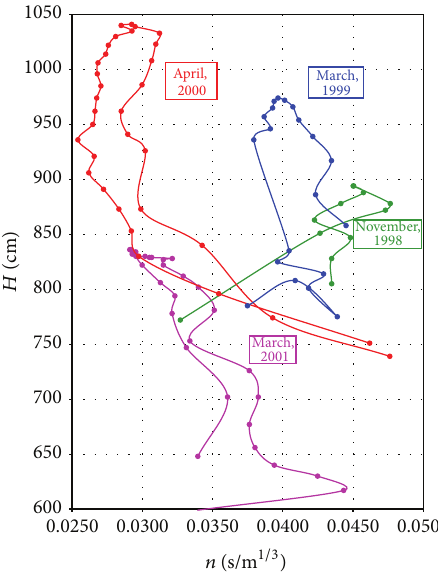
Figure 3: Variation of Manning’s coefficient of friction by water level, flood plain at